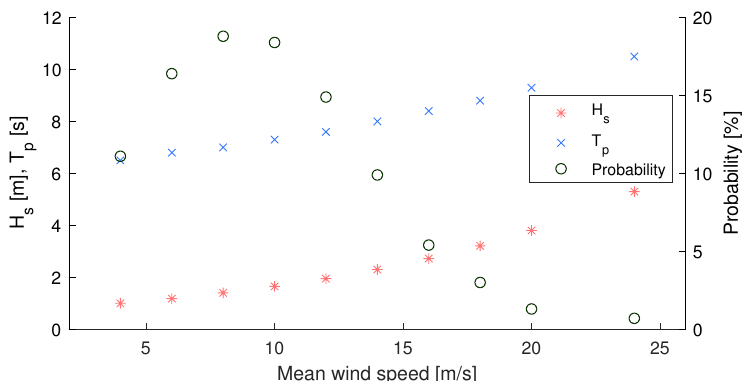
Figure 8. Mean wind speed, H s , T p and probability of occurrence for fatigue load